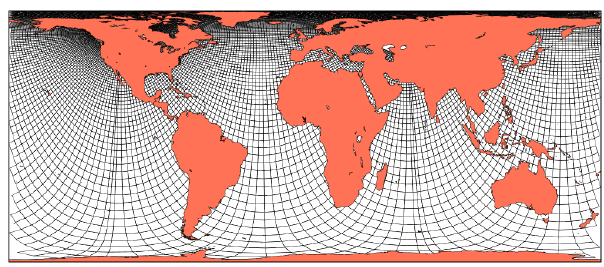
Figure 5. Model grid, mesh indicates groups of 4 by 4 grid cells.